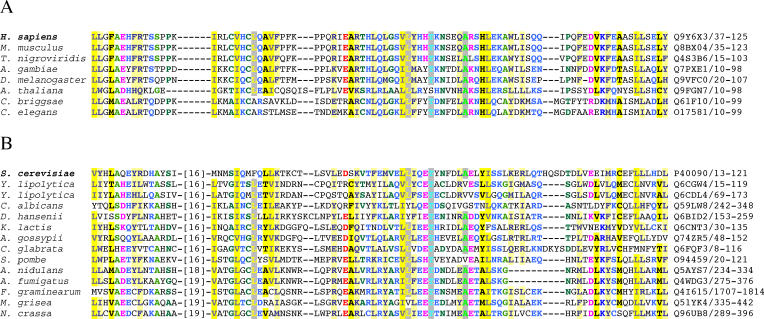
Alignment of the Conserved N-terminal Region of the Scc4/MAU-2 Family(A) Alignment of animal and plant MAU-2 homologs referenced against the human MAU-2 sequence shown at the top.(B) Alignment of fungal Scc4 homologs referenced against the
S. cerevisiae Scc4 sequence shown at the top. Numbers in parentheses at left refer to a short sequence of 16–19 amino acids that has been omitted for clarity. Protein database accession numbers at right are followed by amino acid co-ordinates for the N-terminal sequences that have been aligned. The alignment was made with the MAFFT alignment tool [
62] and colored using the CHROMA software to highlight conserved residues [
63].